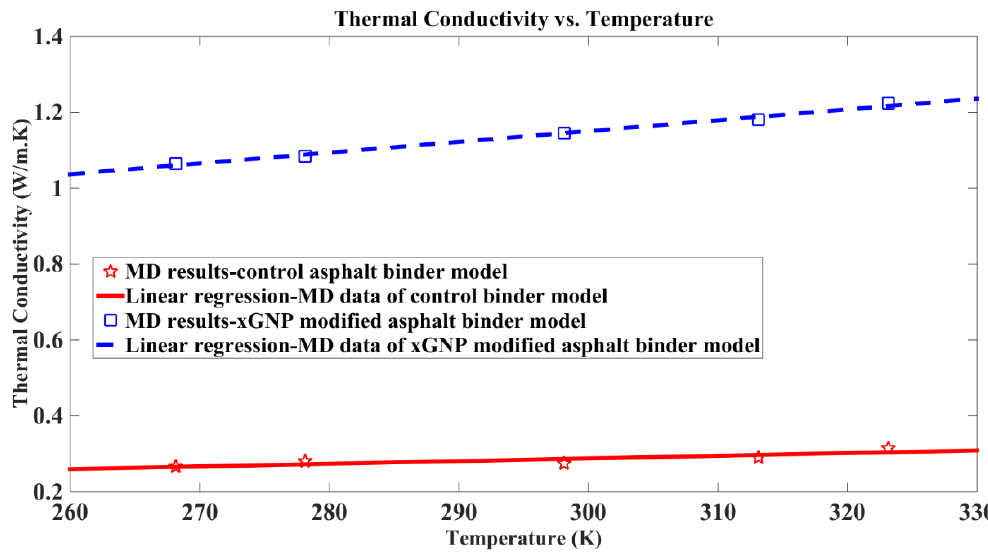
Figure 11. Thermal conductivity results of MD simulations.